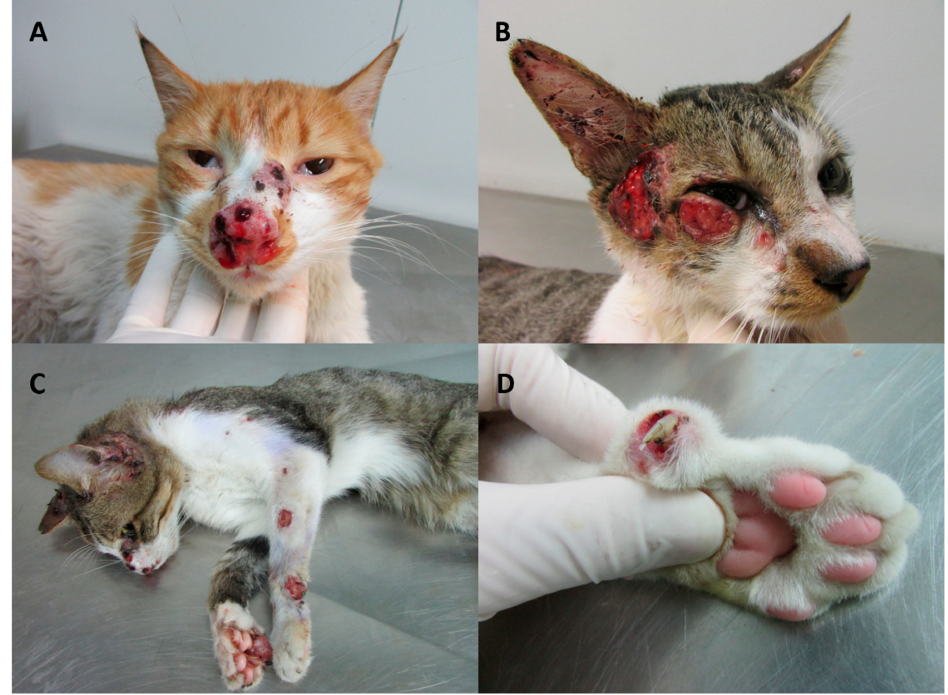
Figure 2. Clinical presentations of feline sporotrichosis. ( A ) Swelling of the nasal region with crusted skin ulcers on the nasal bridge and nasal planum, draining serosanguinous exudate. Serosanguinous nasal discharge. ( B ) Ulcerated skin lesions and crusts on the cephalic region. Epiphora. ( C ) Multiple skin lesions on the cephalic region. Ascending nodular lymphangitis on the left forelimb and tumor-like lesion on the upright paw. ( D ) Paronychia on the forelimb. Photo credit to the Laboratory of Clinical Research on Dermatozoonoses in Domestic Animals (Lapclin-Dermzoo), Evandro Chagas National Institute of Infectious Diseases (INI), Oswaldo Cruz Foundation (Fiocruz). Use of these images was authorized by Lapclin-Dermzoo / INI /